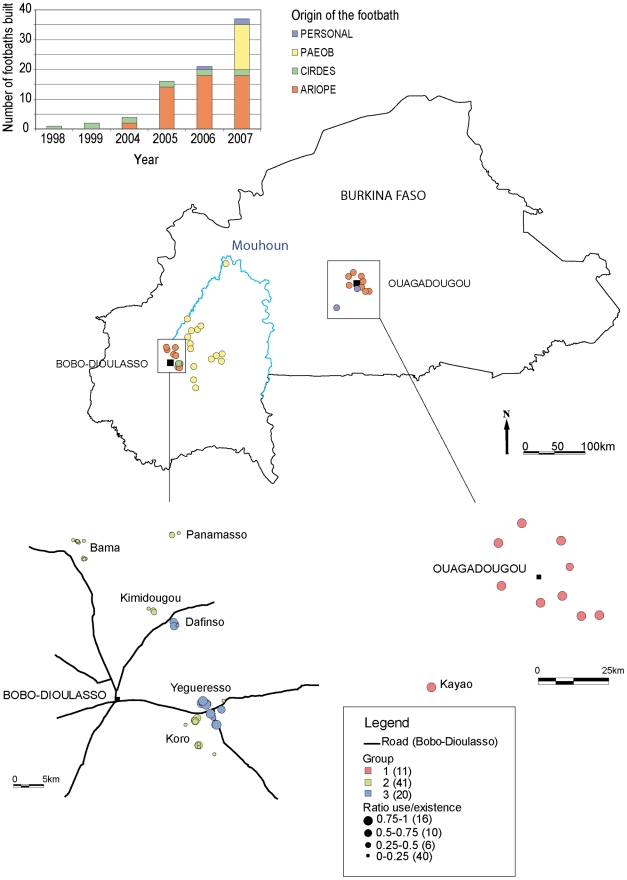
Location of the footbaths in Burkina Faso.At the top, footbaths are described according to the origin of their implementation: built by the Centre International de Recherche sur l'Elevage en zone Sub-humide (CIRDES) for research purposes, funded by the Projet d'Appui au renforcement institutionnel des organisations professionnelles d'éleveurs modernes (ARIOPE development project), funded by the Projet d'Appui à l'Elevage dans l'Ouest du Burkina (PAEOB development project), or built using personal funding. At the bottom, herds are located by their night pens, colored according to the farmer group, and sized according to the ratio of the duration of individual use on the duration of the footbath existence.